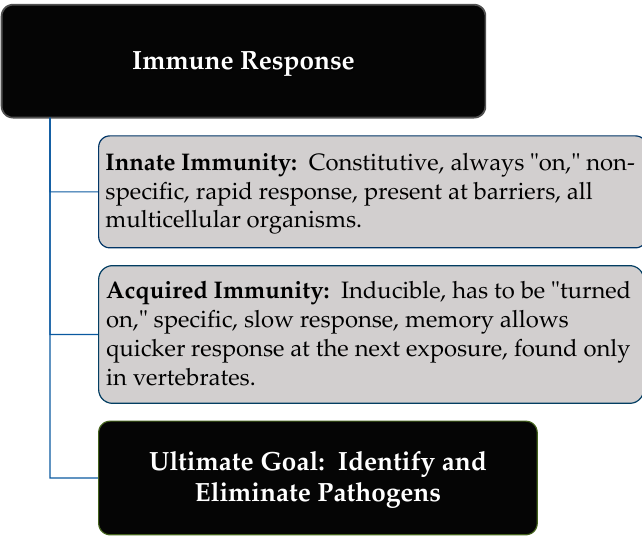
Figure 1. Two distinct divisions of an immune response: Innate and acquire immunity.